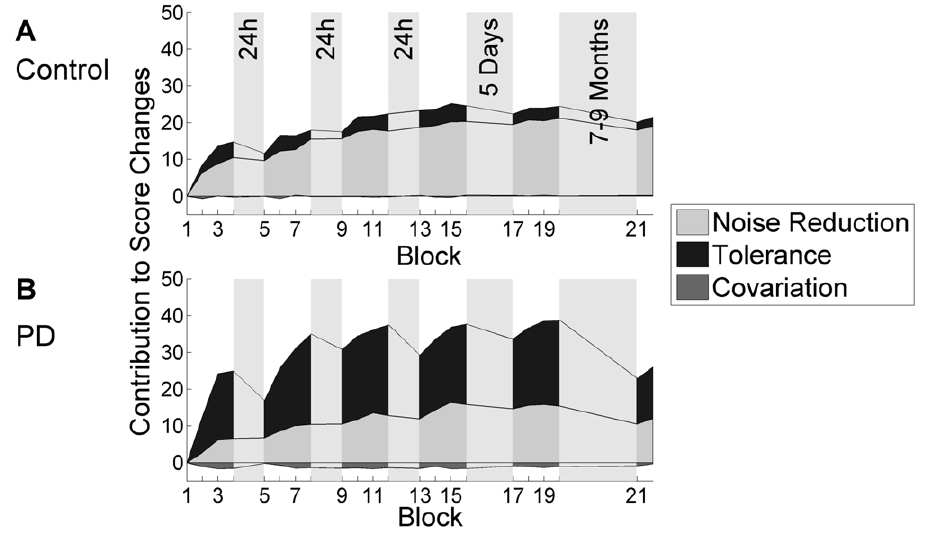
Figure 4. TNC-Contributions to performance changes over practice. Contributions of T , N , and C to performance changes over the course of the five practice sessions and the retention session for the control group ( A ) and PD patients ( B ).